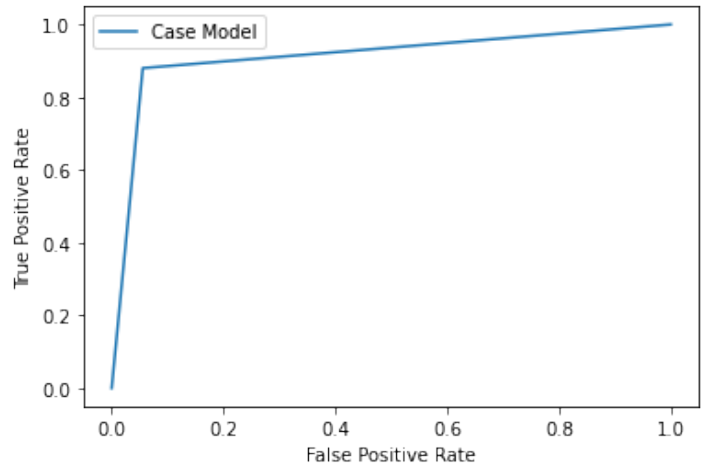
Figure 11. Confusion Matrix of Case Model.